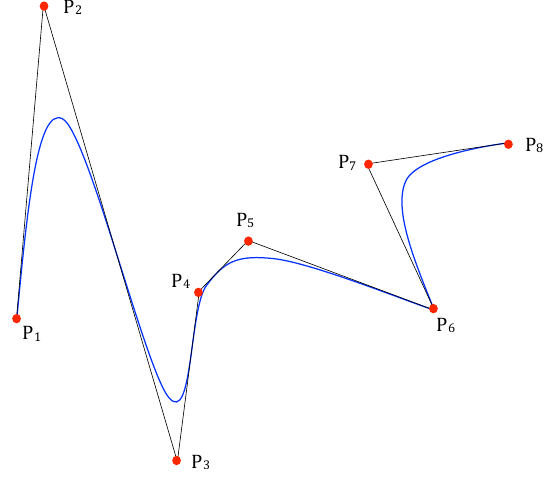
Figure 1: B-spline piecewise quadratic curve in R 2 .